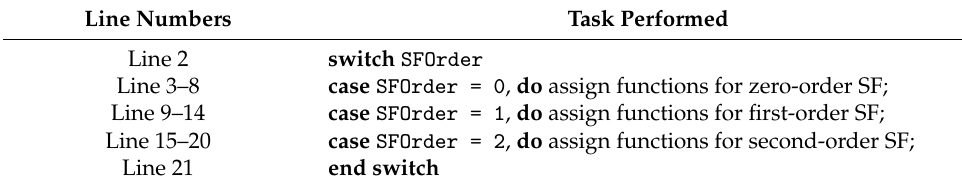
Table 7. SFExpressions algorithm summary.